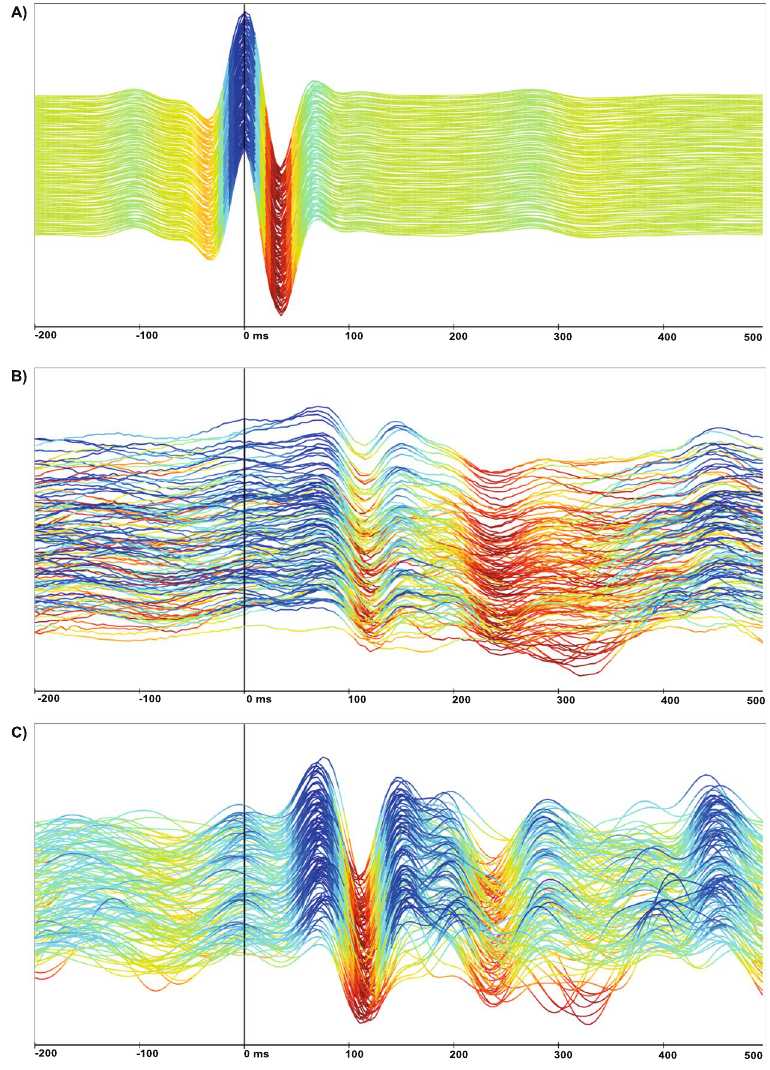
Figure 7. Diagram of 128 consecutive heartbeats in ECG ( A ) and BCG ( B , C ) recording with time dependent analysis by ECG R-wave peak detection at 0 ms in any diagram. For better amplitude visualization, the maxima and minima are visualized with colour gradients in an arbitrary scale; ( A ) The ECG shows a harmonic signal over the whole displayed time during sinus rhythm; ( B ) Sinus rhythm; genuine BCG signal deteriorates due to signal superposition of breathing and movement artefacts. ( C ) Sinus rhythm (filtering the BCG signal) exposes a typical mechanical amplitudes sequence of each heartbeat but also shows the ambiguous and intraindividually variable nature of mechanical heartbeat